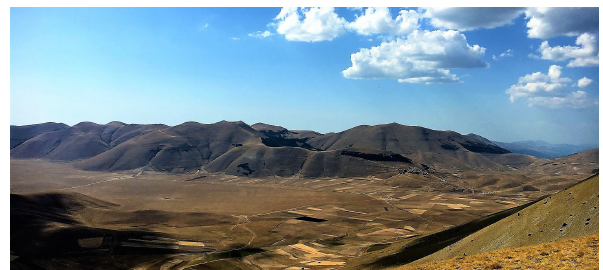
Figure 11. A view of Pian Grande. The plain has N–S direction and mean elevation of 1300m.